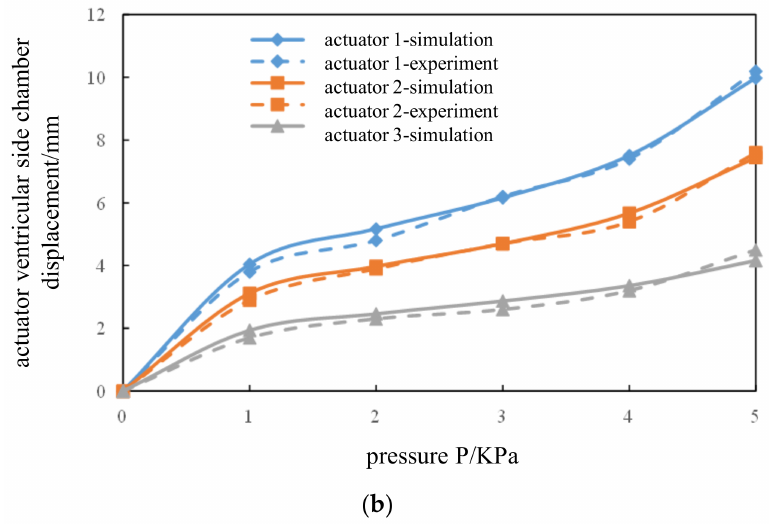
Figure 8. Experimental results of fiber-constrained annular flexible actuators. ( a ) Pressure- displacement experiment and simulation results; ( b ) relationship between air pressure and extrusion pressure of the three actuators.